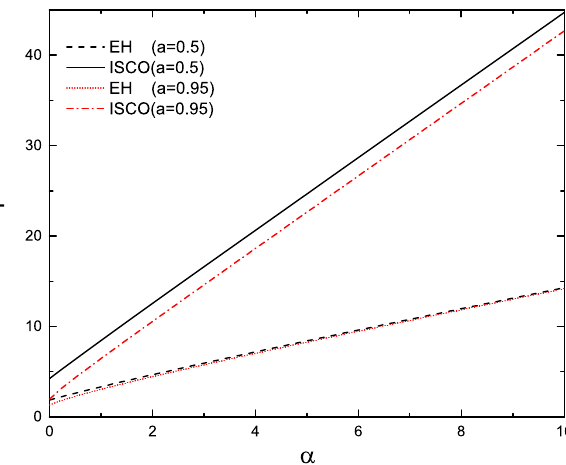
Fig. 10 Eventhorizons(EH)andISCOsoftheKerr-MOGblackholes. The difference between ISCO and the outer horizon (EH) of Kerr-MOG black hole increases as parameter α